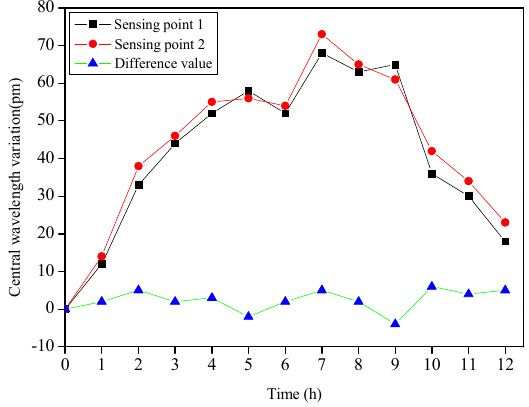
Figure 9. The central wavelength variations of two sensing points.